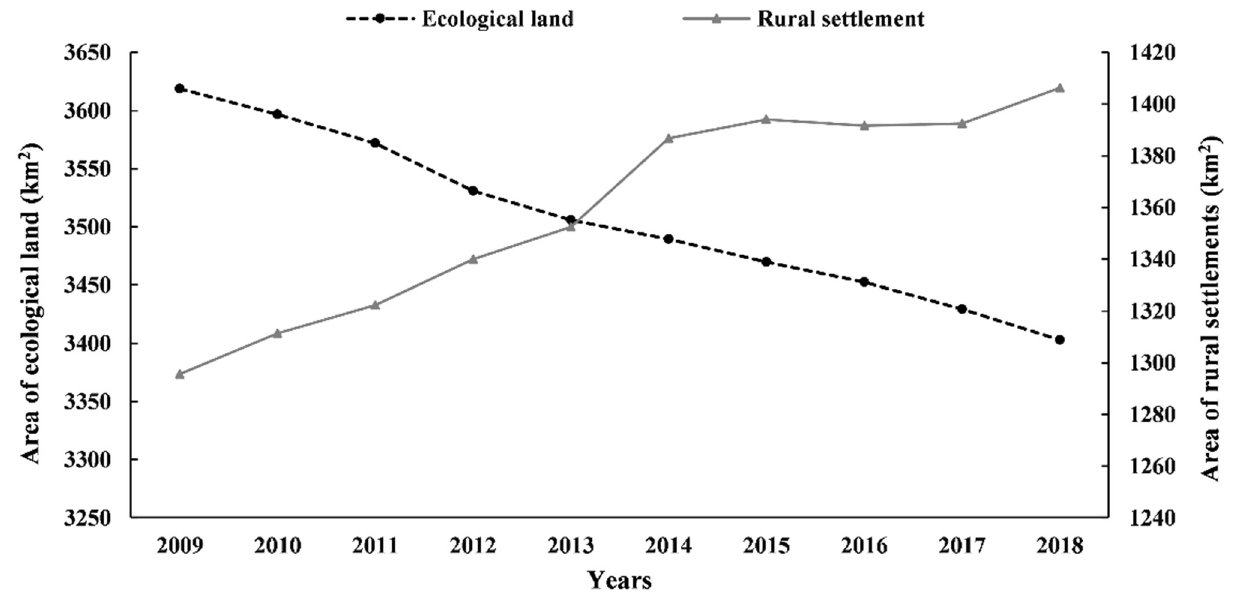
Figure 2. Changes in ecological land and rural settlements in Nantong.